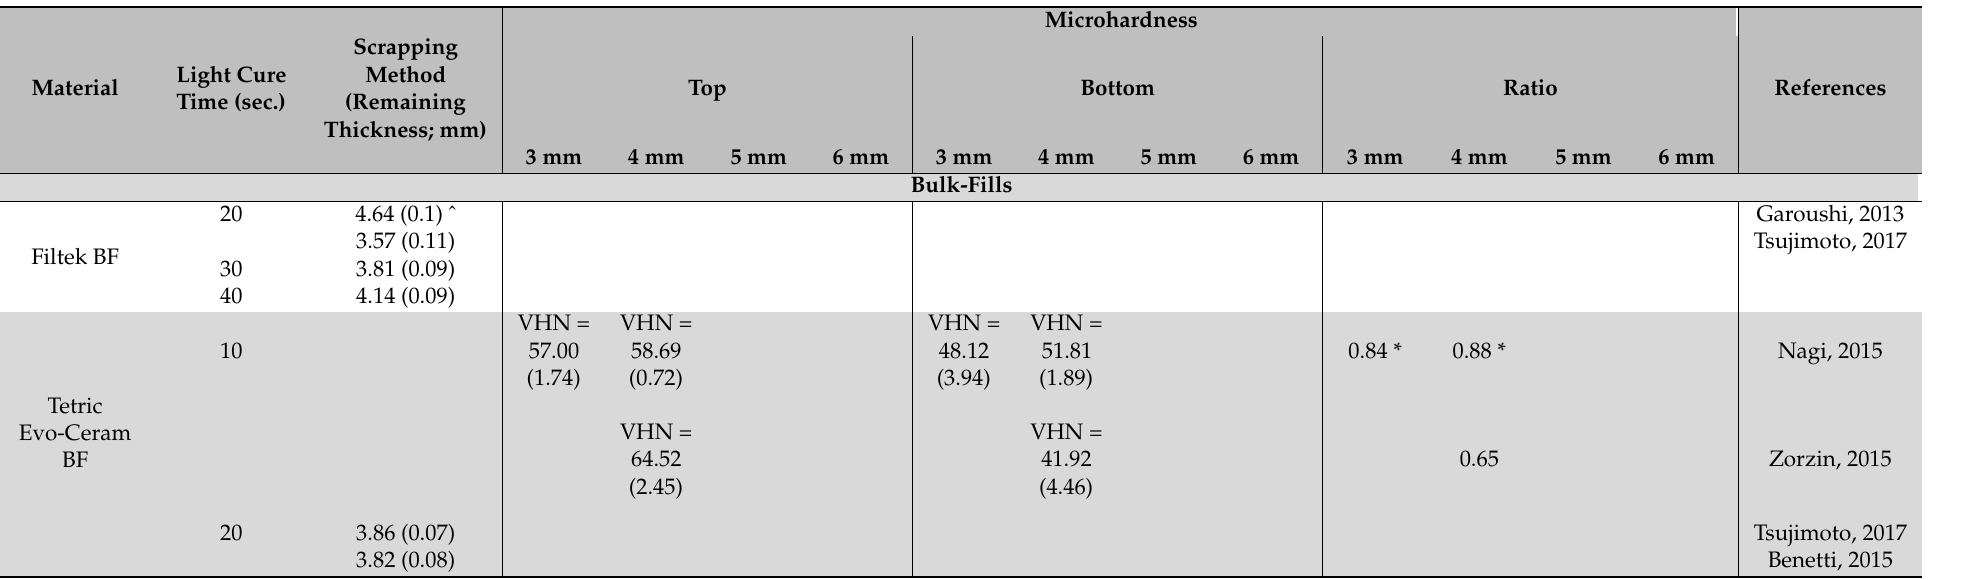
Table 4. Means and standard deviations (in parenthesis) of depth of cure data depicted from indirect